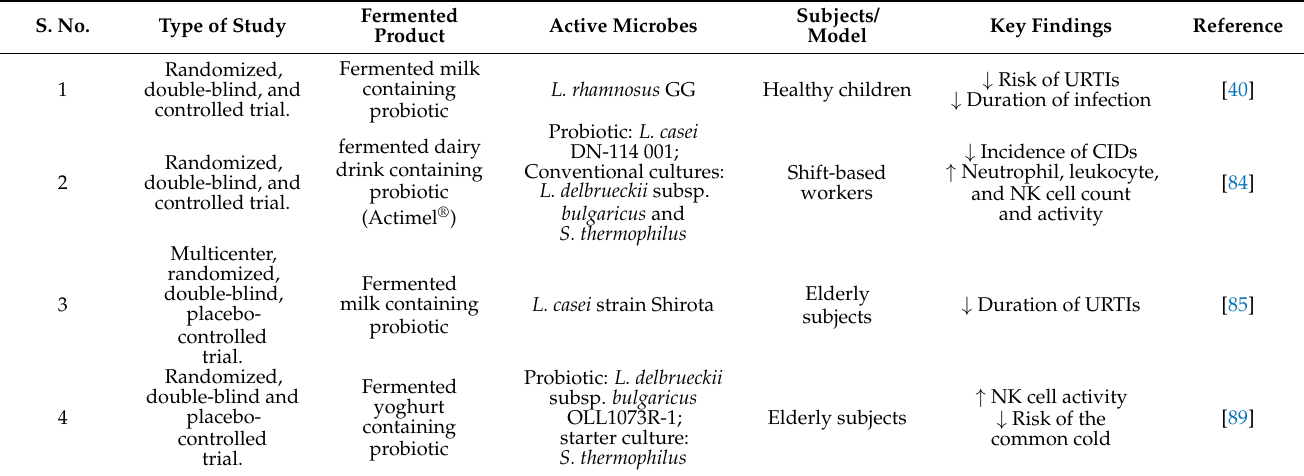
Table 1. The reported beneficial effect of FFs against respiratory tract